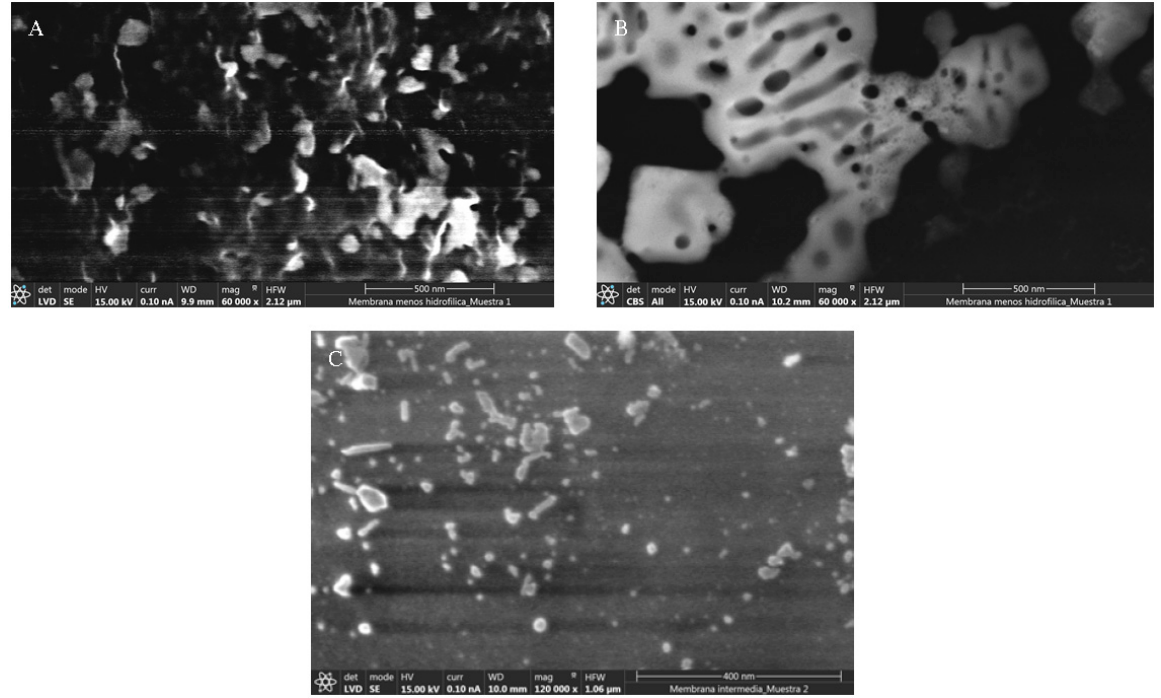
Figure 2. FE-SEM images of the cross section of SPES 1 ( A ), and the surfaces of SPES 1 ( B ) and SPES 2 ( C ) membranes.